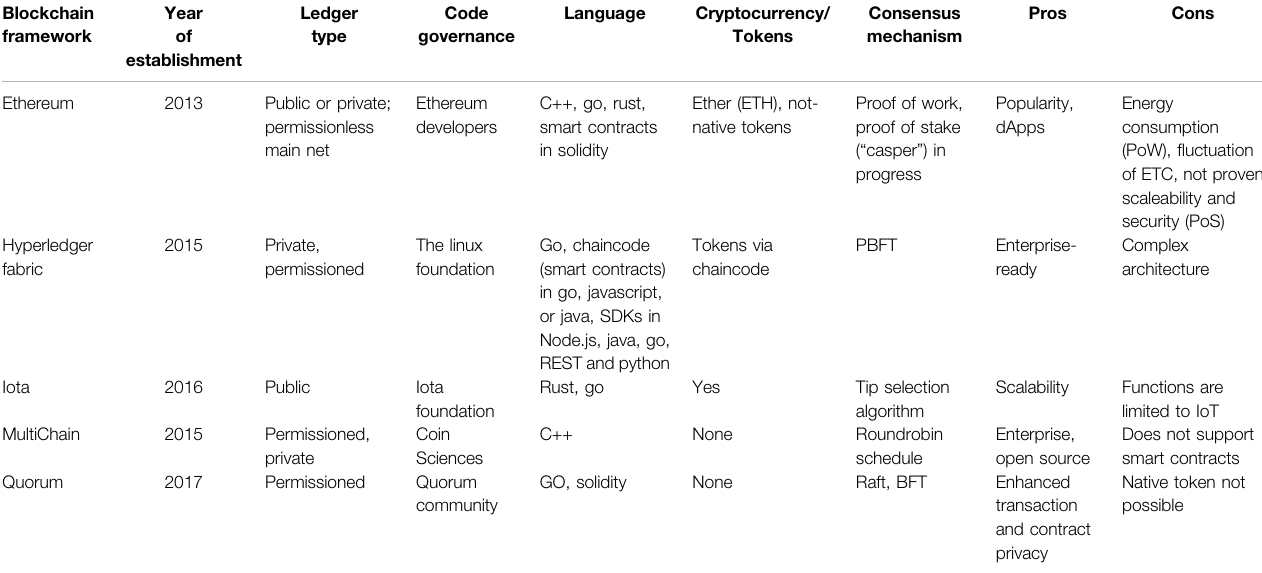
TABLE 1 | A list of blockchain frameworks most used in agrifood. Blockchain